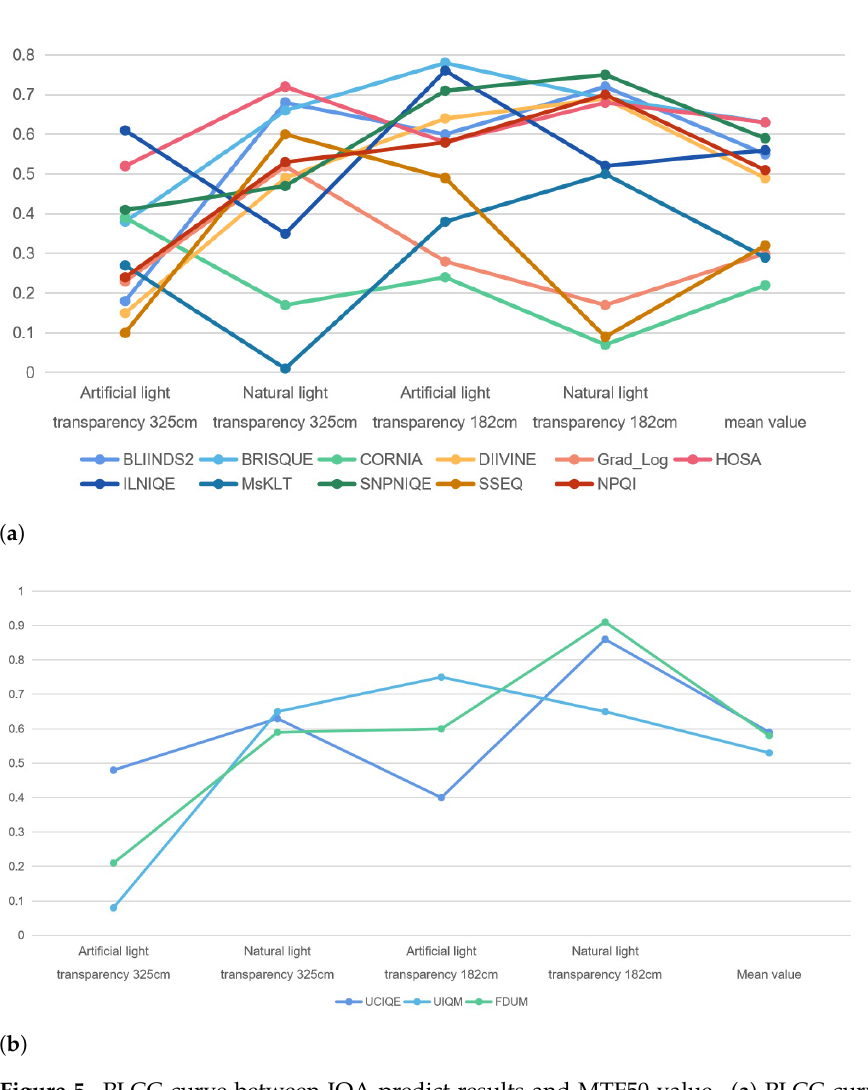
Figure 5. PLCC curve between IQA predict results and MTF50 value. ( a ) PLCC curve between results of natural IQA methods and MTF50 value, ( b ) PLCC curve between results of underwater IQA methods and MTF50 value.